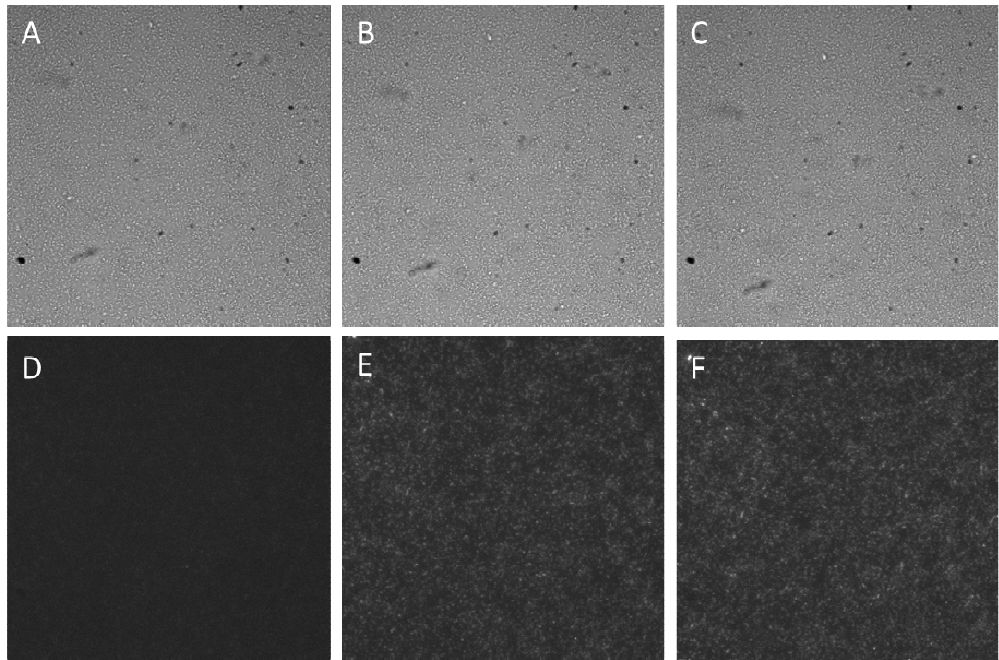
Figure 7. Brightfield and Fluorescence time lapse of cells in the microfluidic growth chamber. ( A ) Brightfield image at t = 0 s. ( B ) Brightfield image at t = 1.5 h. ( C ) Brightfield image at t = 3 h. ( D ) Fluorescence image at t = 0 s. ( E ) Fluorescence image at t = 1.5 h. ( F ) Fluorescence image at t = 3 h.